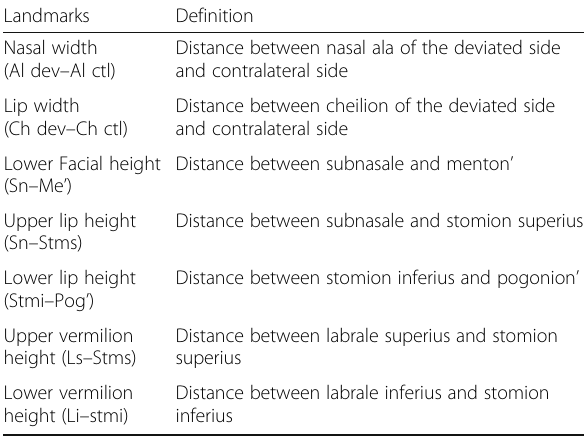
Table 3 Description of soft tissue linear measurements in the study